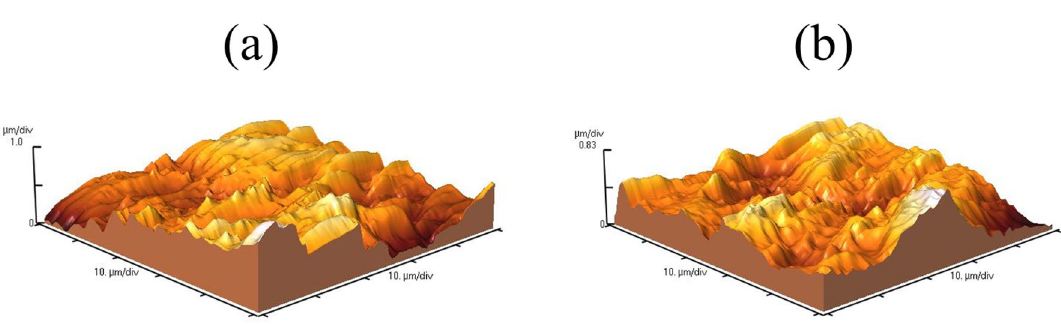
Figure 7. AFM analysis of MS immersed in 1 M HCl solution without ( a ) and with 1000 ppm DPH ( b ) after 4 h.